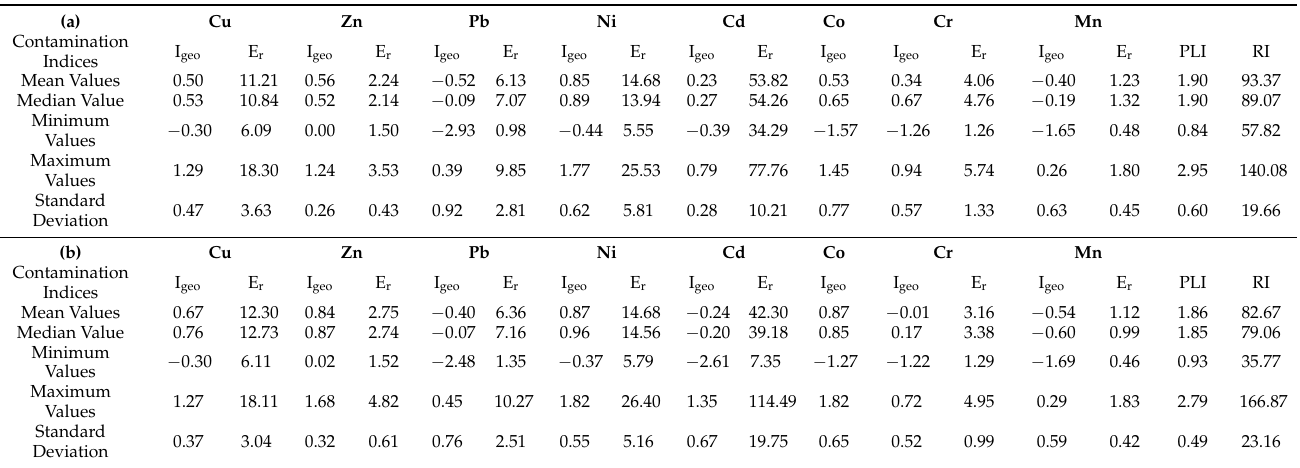
Table 4. (a) Geo-accumulation index (I geo ), ecological risk factor (E r ), potential ecological risk index (RI), and pollution load index (PLI) for the heavy metals before the COVID-19 pandemic. (b) Geo- accumulation index (I geo ), ecological risk factor (E r ), potential ecological risk index (RI), and pollution load index (PLI) for the heavy metals during the COVID-19